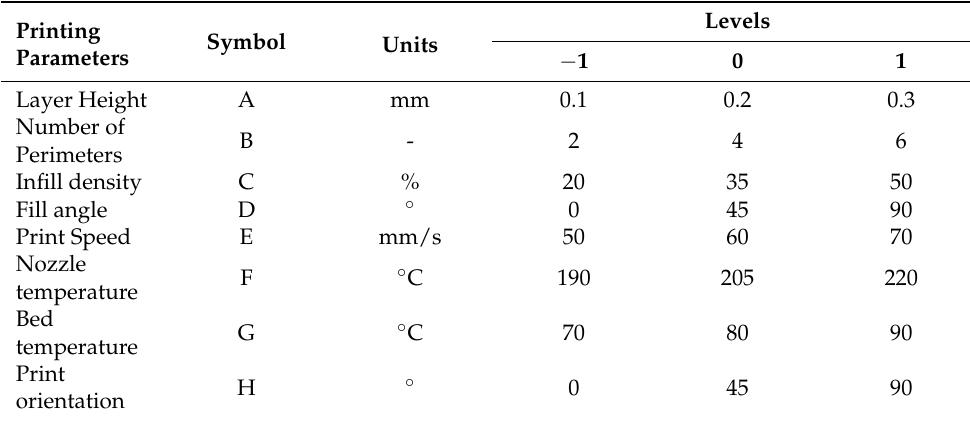
Figure 4. Schematic of FDM 3D printer with associated printing parameters and print orientations. Table 1. Levels for printing